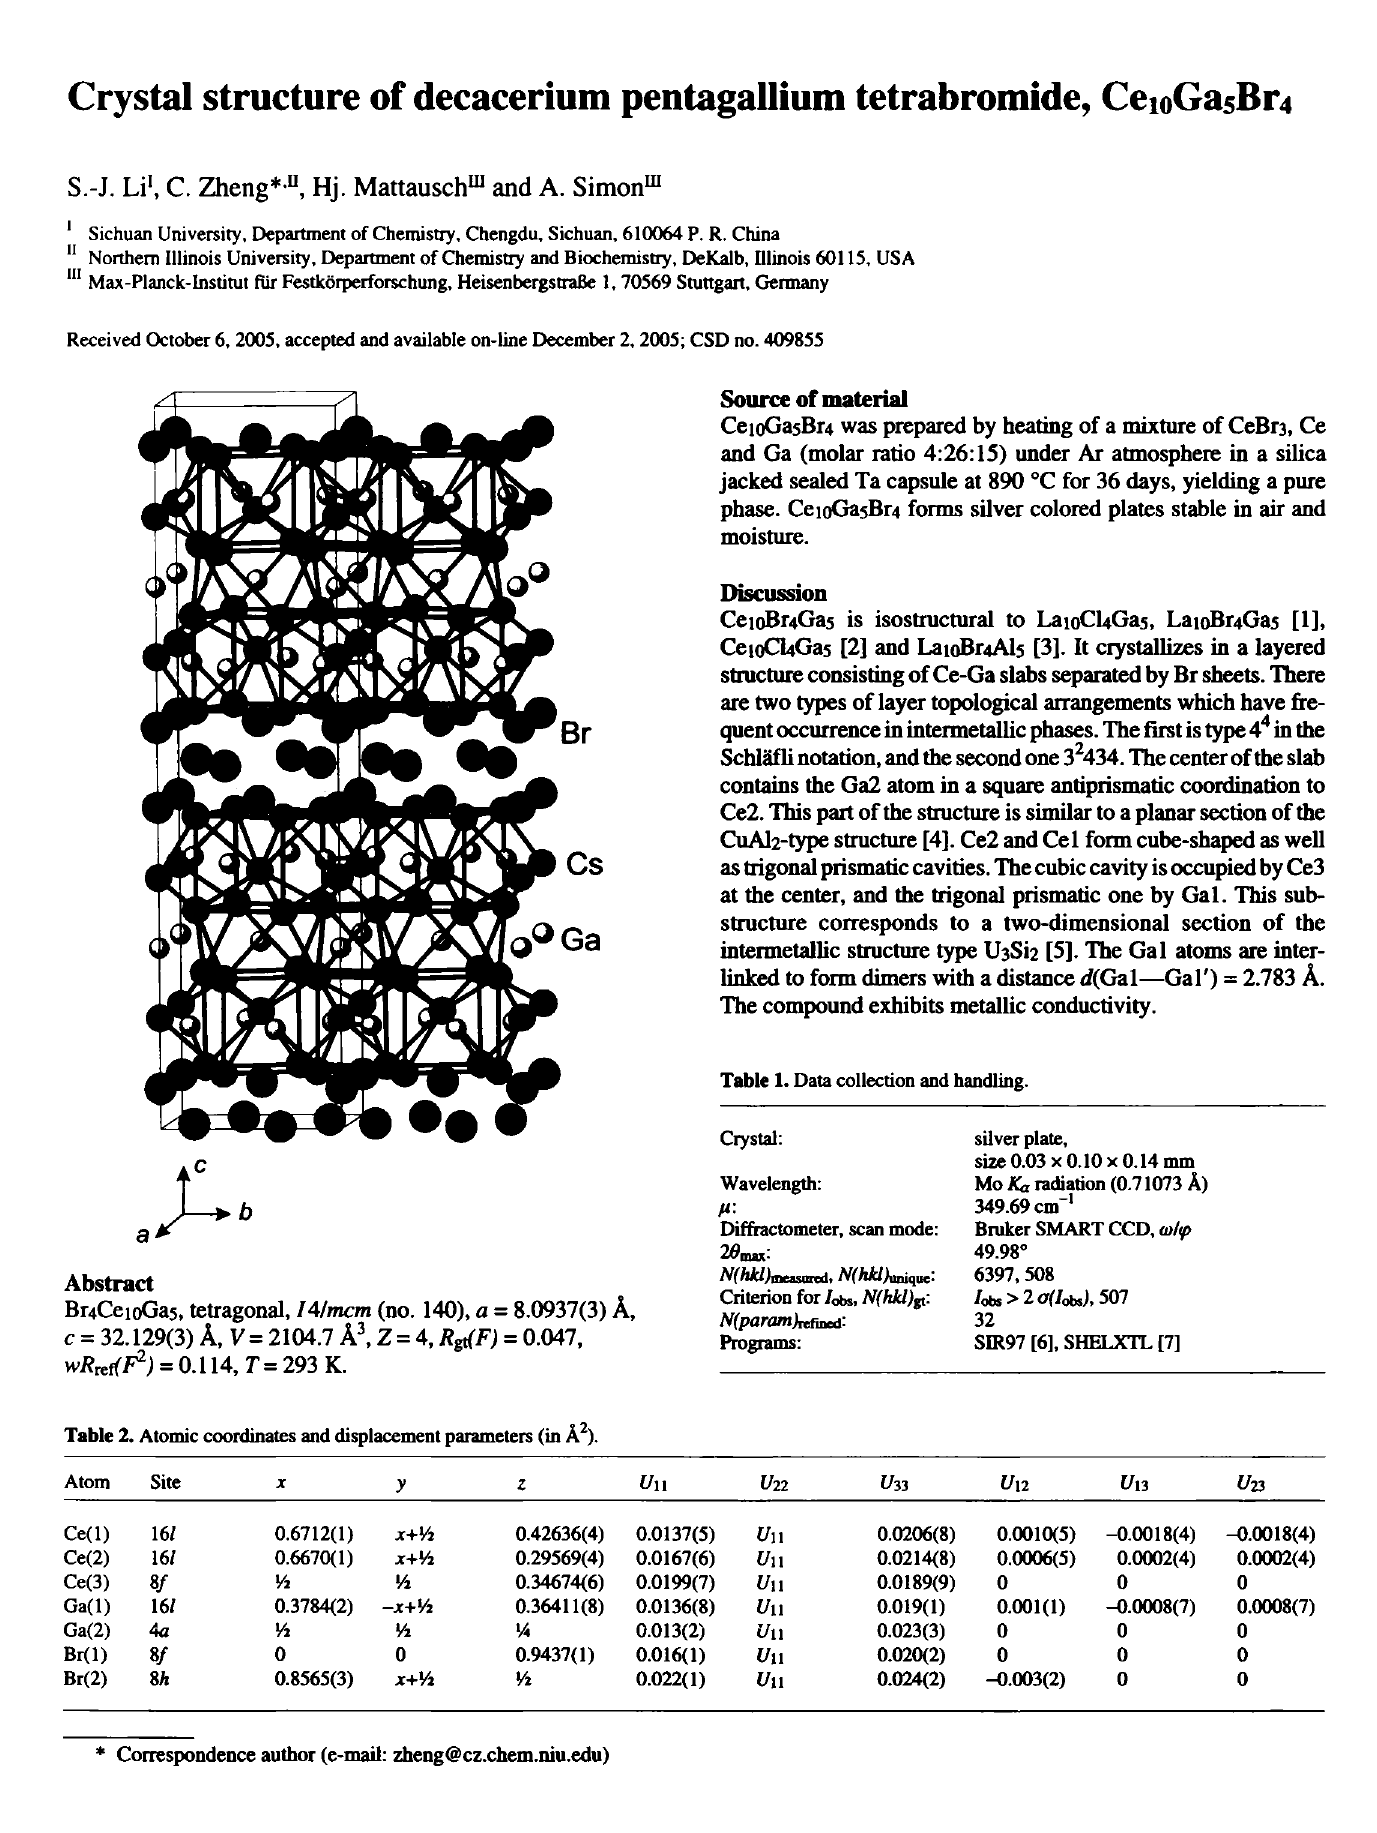
Table 2. Atomic coordinates and displacement parameters (in Ä 2